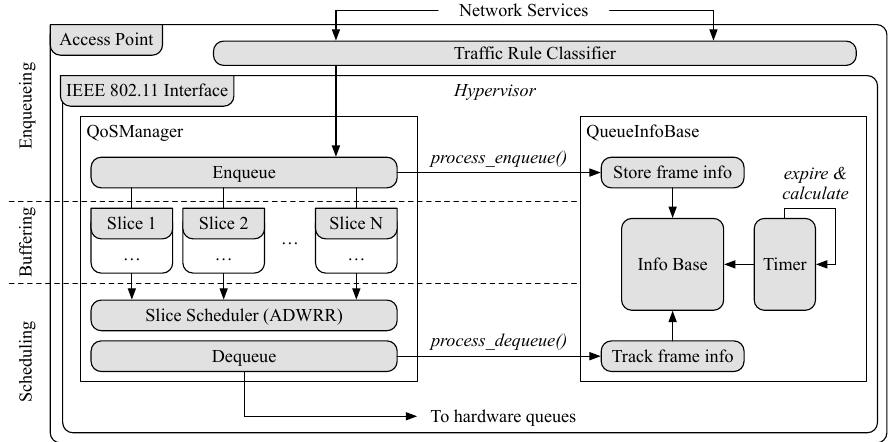
Figure 4. Queueing delay monitoring in the simplified queue structure and data flow in an